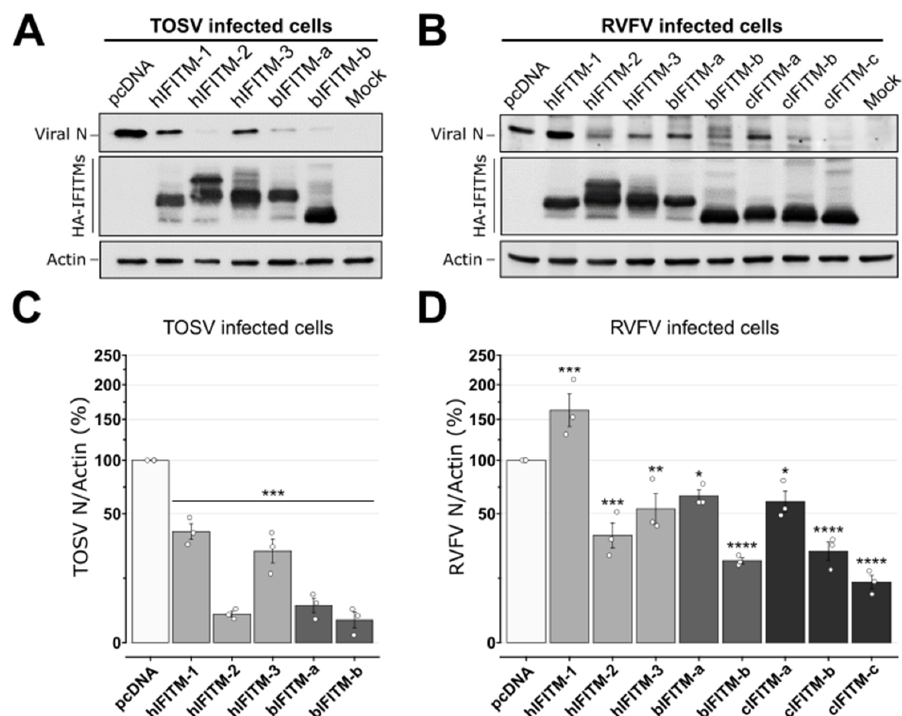
Figure 4. Western blot analyses of TOSV and RVFV N proteins from infected cells expressing the different IFITMs. Infection assays with TOSV ( A , C ) or RVFV ( B , D ) were performed in HEK293T cells expressing or lacking (pcDNA3.1) the different IFITMs, as indicated. Cells were collected at twenty-four hours post-infection and analyzed by Western blot with antisera raised against TOSV or RVFV N proteins, HA (to detect IFITMs), or actin, as specified. Each experiment was performed three times, independently. Representative blots are presented in panels ( A , B ). Signals of TOSV and RVFV N proteins, and actin proteins were quantified from, at least, three independent experiments using Image Lab software. The ratios of TOSV N/Actin ( C ) and RVFV N/Actin ( D ) are reported on the graphs and are relative to those obtained in control cells (pcDNA), arbitrarily set as 100%. Statistical analyses were performed with a Kruskal–Wallis test, and significance (compared to pcDNA control) is presented as follows: p < 0.05 (*), p < 0.01 (**), p < 0.001 (***) and p < 0.0001 (****). hIFITM-1,